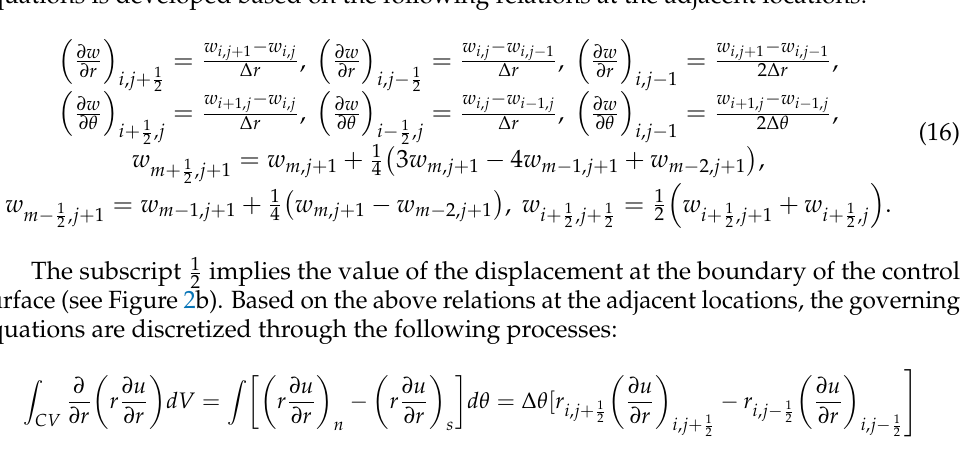
Figure 2. Schematic diagram for finite volume method: ( a ) Discretization of circular disk domain, ( b ) notations of finite control volumes. The finite surface mesh is denoted by